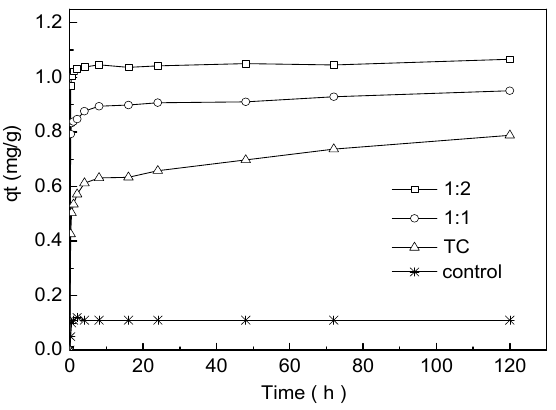
Figure 4. Adsorption kinetics of TC by water hyacinth roots in the absence or presence of Cu(II). Experimental conditions: [TC] = 50 µM, [Cu 2+ ] = 0, 50 and 100 µM, respectively.